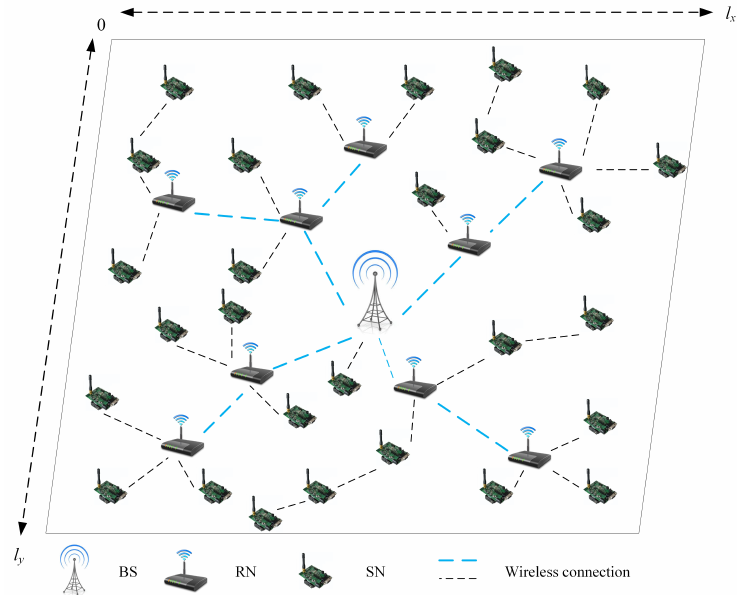
Figure 1. TT-WSN